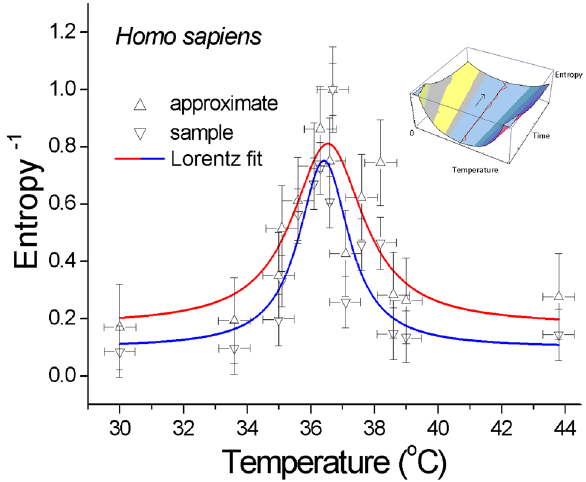
Figure 1. Inverse of the approximate ( S a ) (or sample— S s ) dynamic entropy as a function of temperature for an isolated drop of human blood (normalised). The points, which were calculated from an experimental time series for the extracellular ionic fluxes, yielded the critical temperature T c = 36.54 ± 0.07 °C (36.42 ± 0.16 °C) with a half-width of 2.67 ± 0.12 °C (1.86 ± 0.68 °C). The solid red (blue) line corresponds to the Lorentz fit with the determination coefficient R 2 = 0.72 (0.75), which is smoothed by the B-spline. The temperature was measured at 20 min intervals (time series consisted of 5000 points; sampling 4.1 Hz) with an accuracy of ± 0.5 °C; the calculated y error = 0.15 (0.09). The errors are represented by the drone-like objects in the plot. The calculation in R was performed on the detrended raw data from a number of (15 × 5000 × 2) time series. The data in the right parenthesis above was calculated for S s . Inset Illustration of the “valley of entropy” and “arrow of time” (see